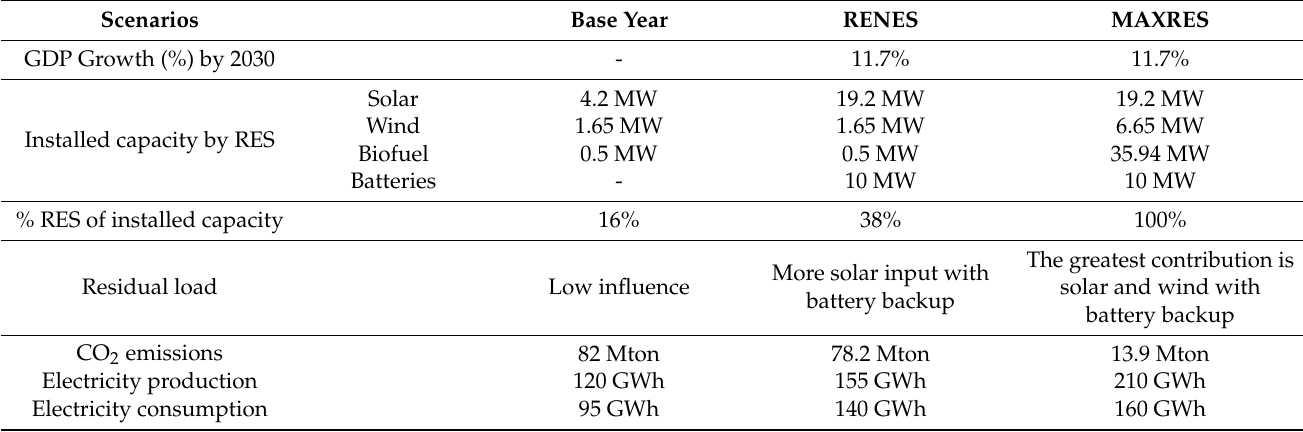
Table 1. Scenario inputs and